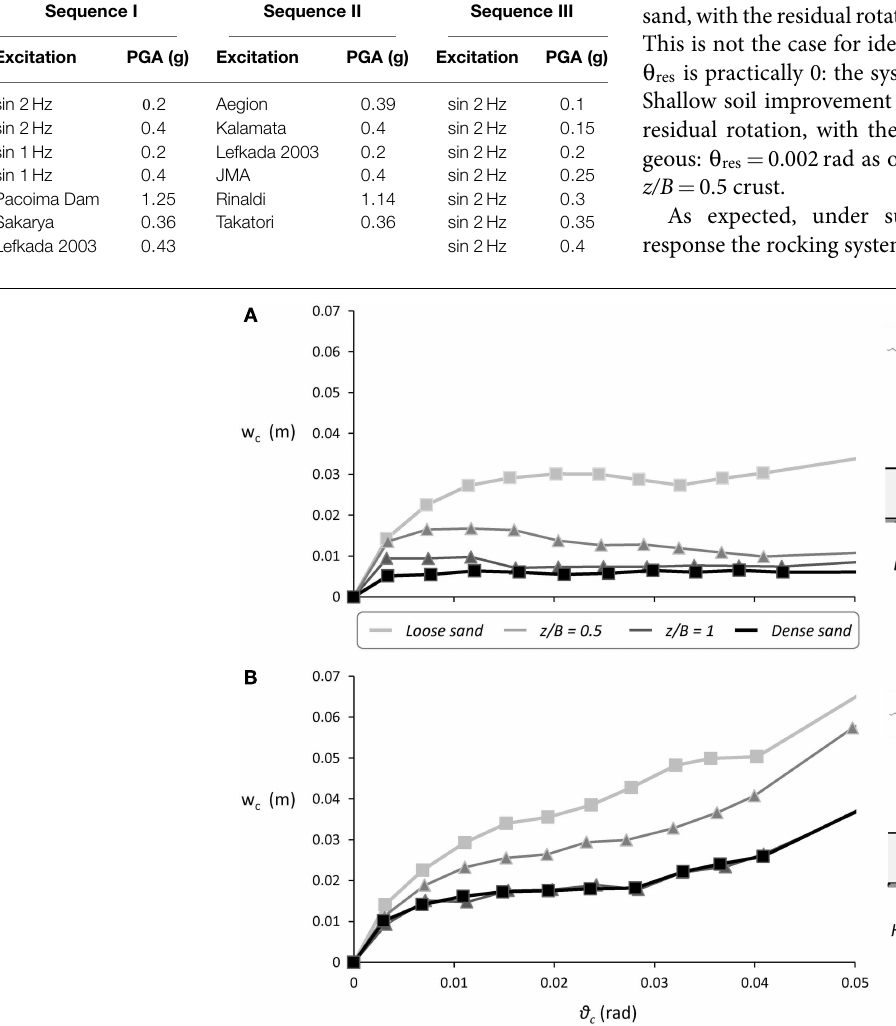
Fr ontiers in Built Environment |